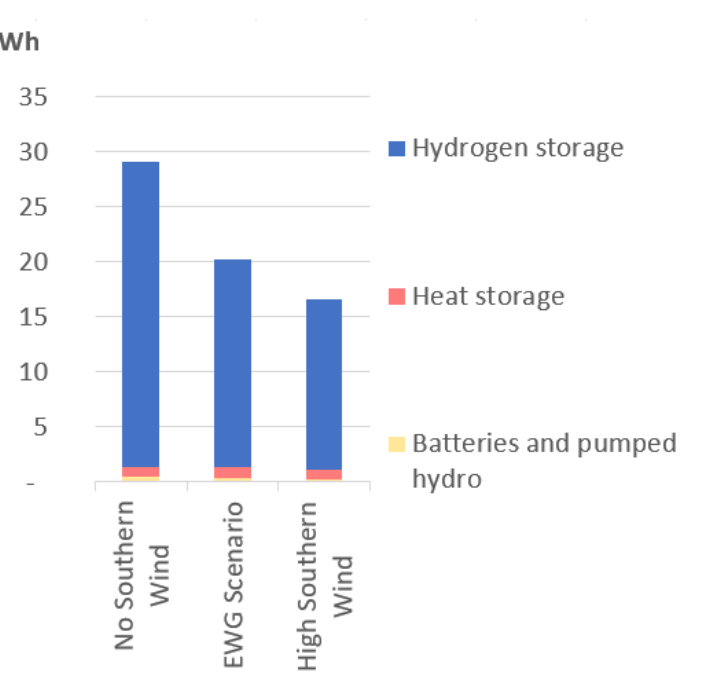
Figure 7. Capacities of storage